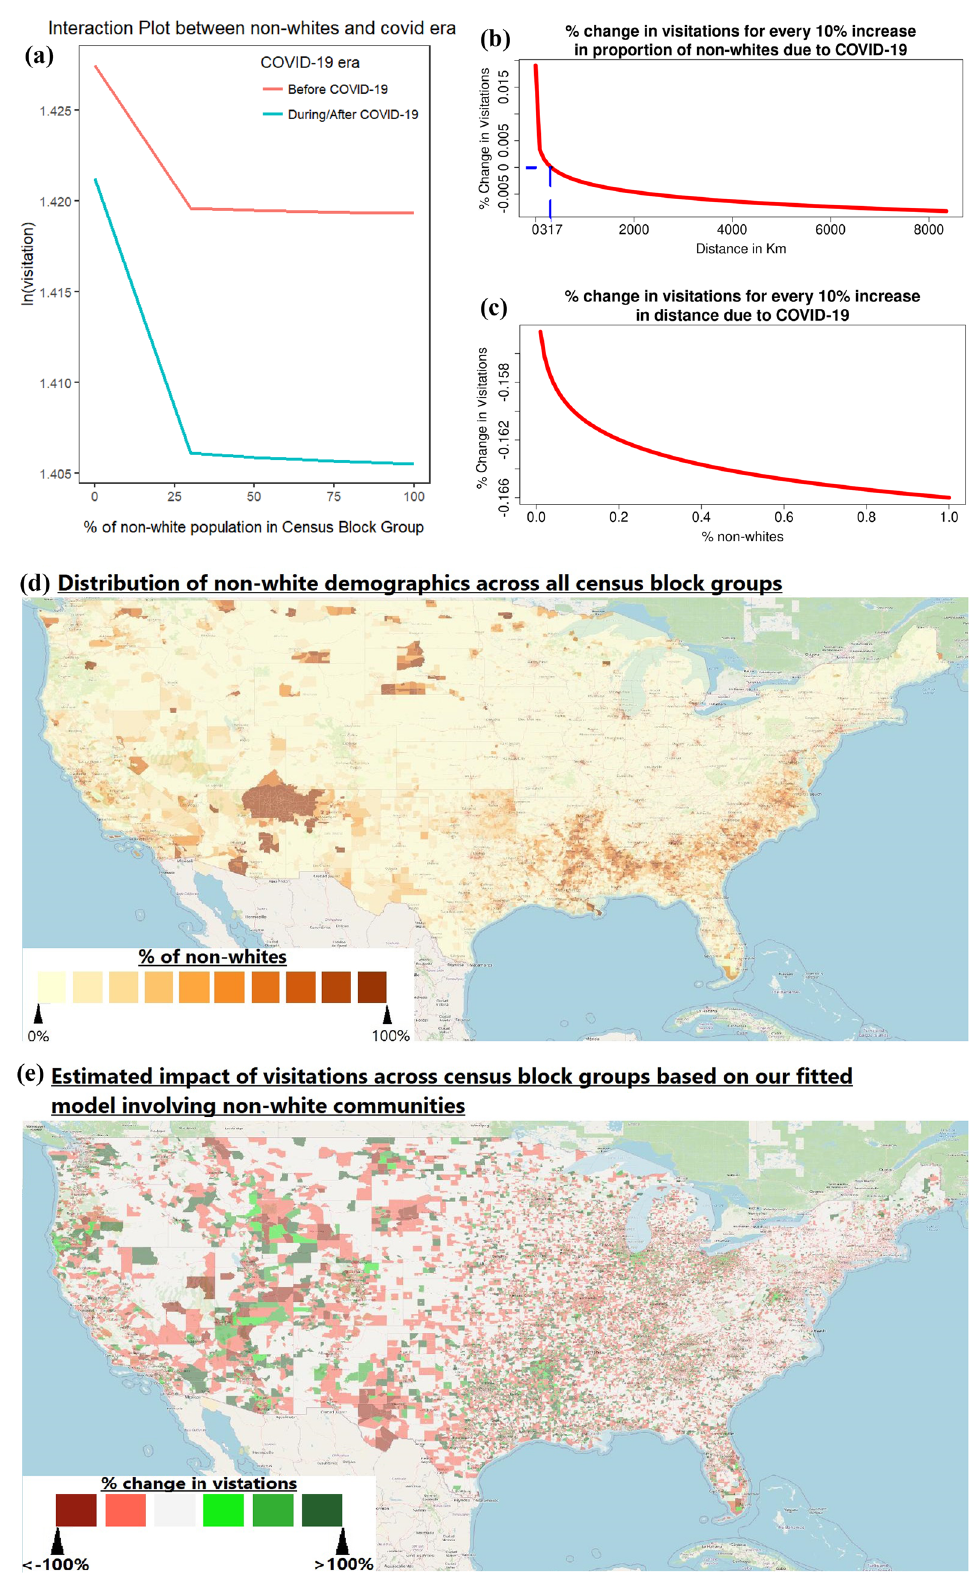
Figure 3. Illustration of the of impact of COVID-19 towards visitations to national parks from non-white communities. ( a ) On the left reflects the interaction plot of percent of non-whites in a census block group and its impact on park visitations due to COVID-19. ( b , c ) On the right reflects changes of visitation to each national park due to COVID-19 for every 10% increase of the proportion of non-whites and distance travelled respectively. ( d , e ) Allows us to compare the non-white demographics across all census block groups and our estimated impact on their overall visitation figures to national parks due to COVID-19, respectively. The maps were generated using QGIS 25 , with the map layers being facilitated by OpenStreetMaps 26